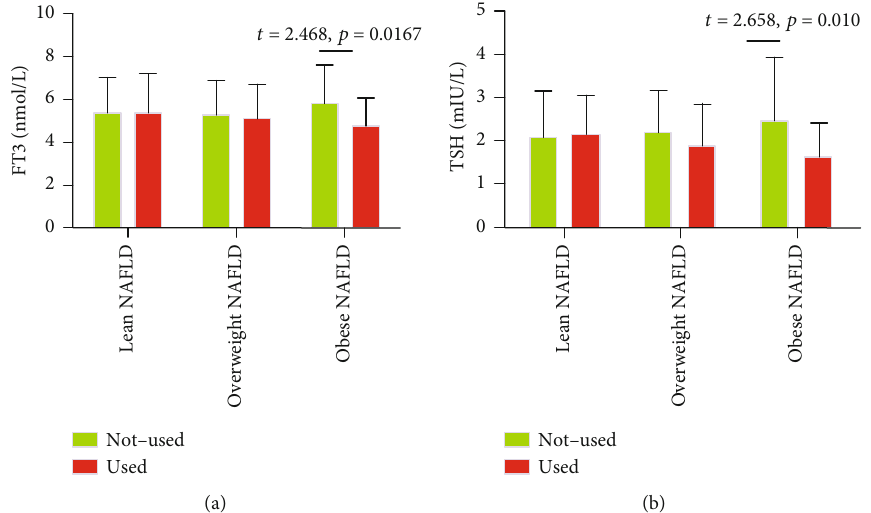
Figure 1: Comparison of serum concentrations of FT3 (a) and TSH (b) between NAFLD patients who used and did not use metformin, strati fi ed by